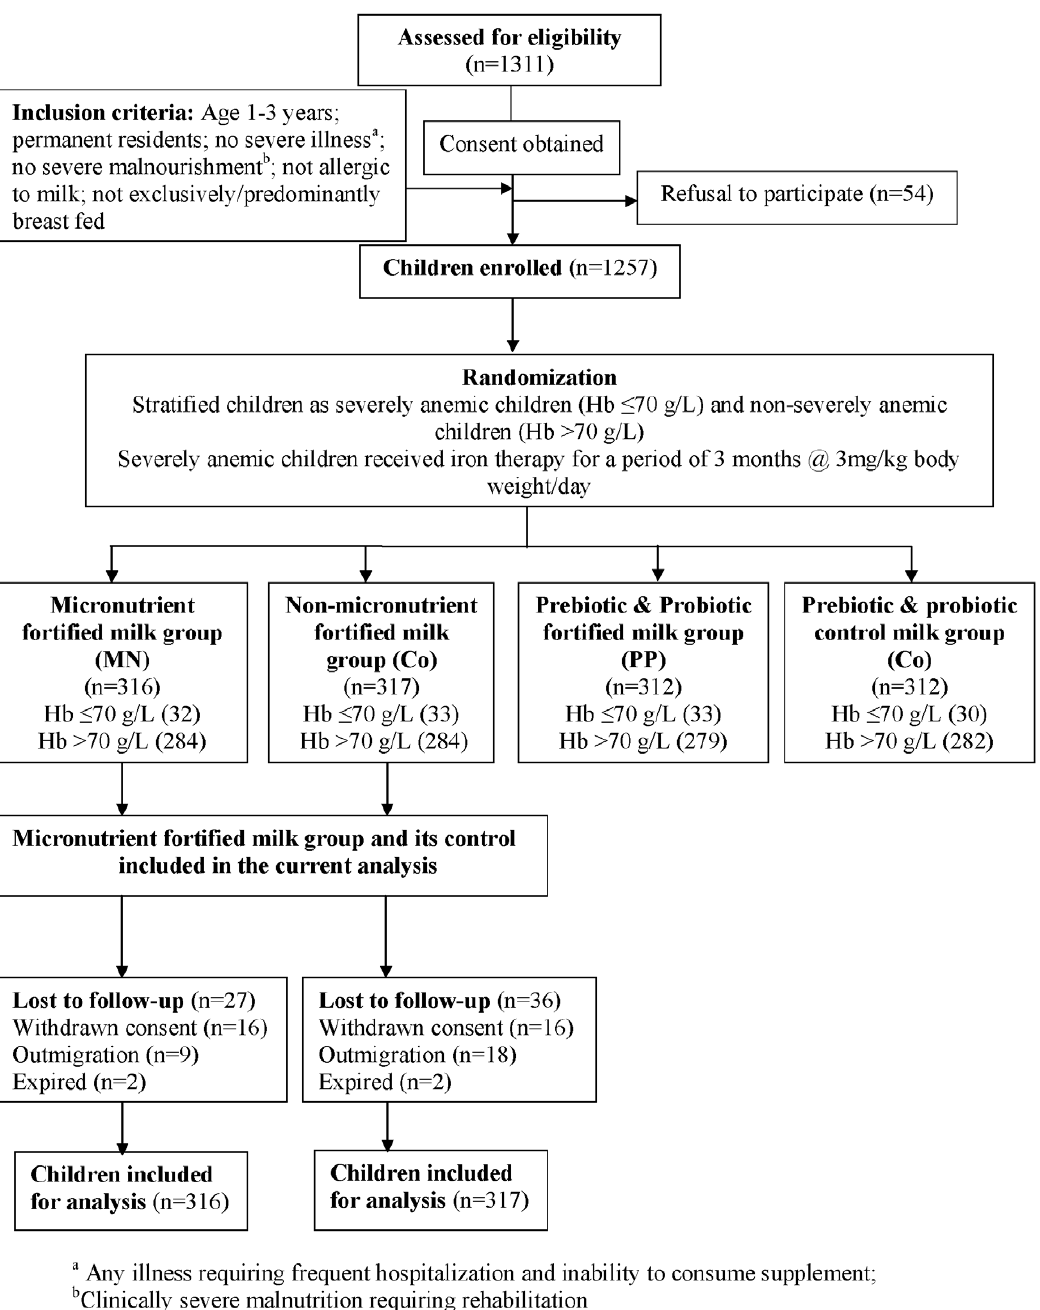
Figure 1. Schematic flow of the participants in the study.